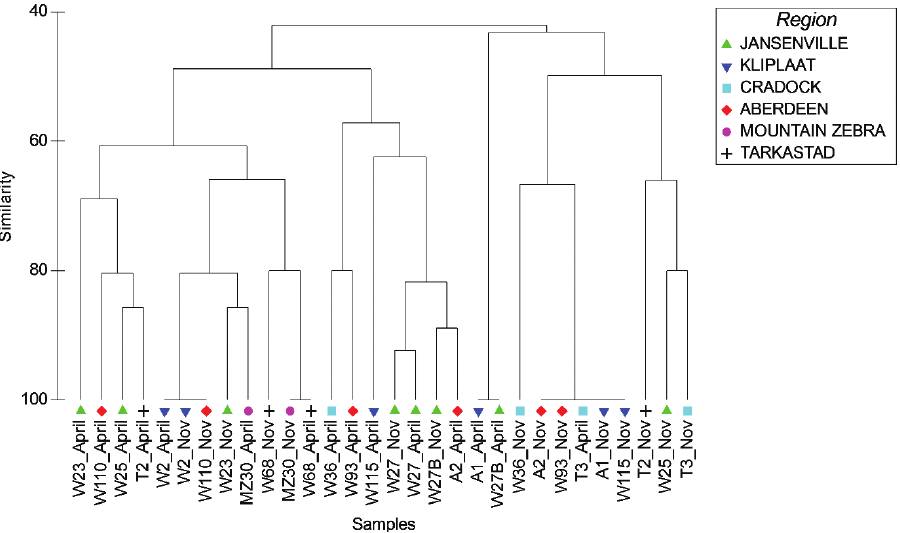
Figure 2. Dendrogram plot depicting the Bray-Curtis similarity of large branchiopod assemblages among sites sampled in the Eastern Cape Karoo. Sites are coded according to the season sampled (spring – November 2014 vs autumn – April 2015) and symbols indicate the sub region in which each site occurs, by reference to the nearest town name (with the exception of sites occurring within the Mountain Zebra National Park, coded as ‘Mountain